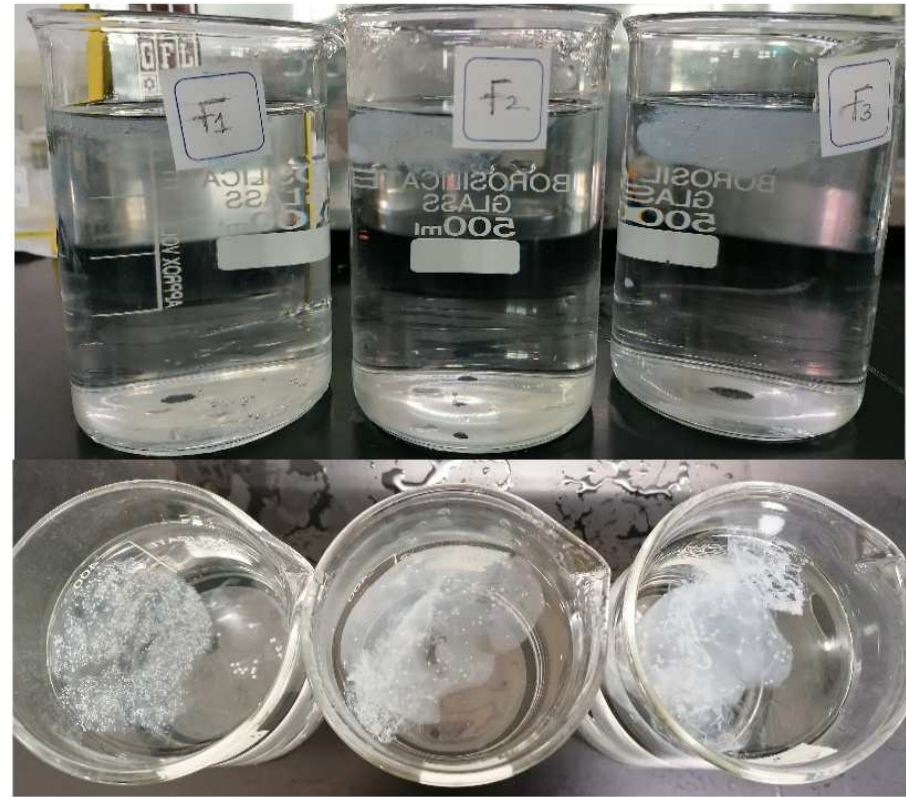
Figure 3. Photographs of formulations F1–F3 depicting the in vitro floating behavior of the oral raft- forming in situ gelling systems of